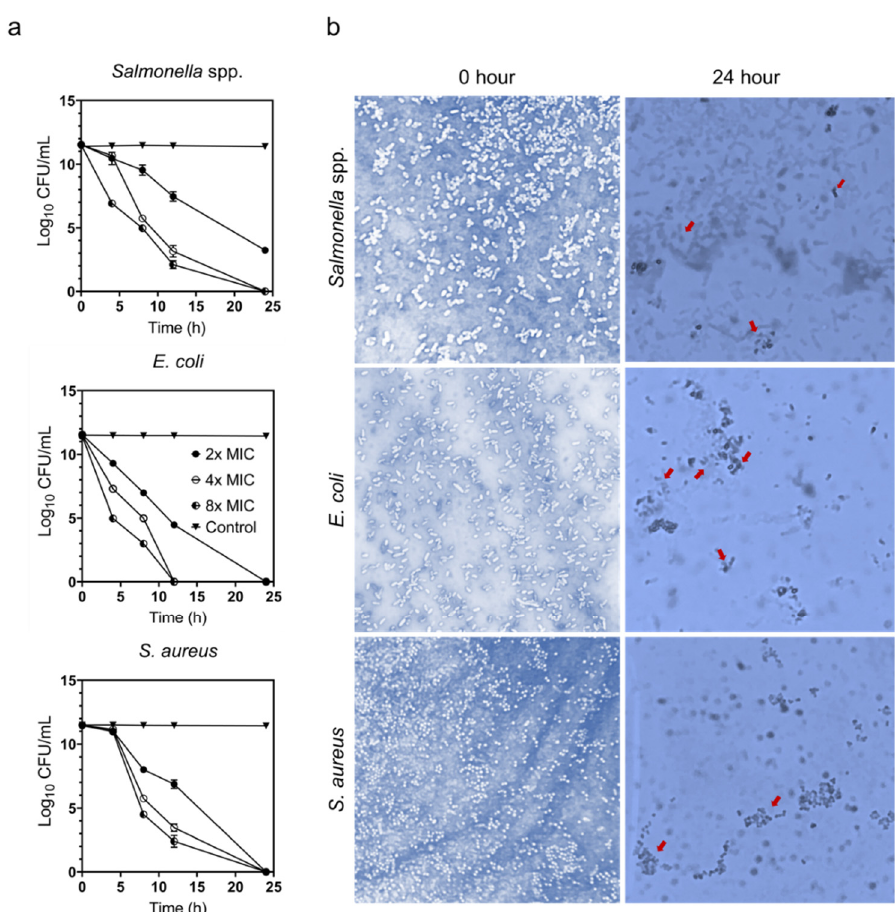
Figure 5. ( a ) Time–kill assay based on cell viability (log 10 CFU/mL) on the poultry-associated foodborne pathogens, Salmonella spp., E. coli , and S. aureus at the concentrations of 2×, 4×, and 8× MIC at different time intervals (0, 4, 8, 12, and 24 h). Bars represent the standard deviation of the mean for three replicates. ( b ) Trypan blue dye exclusion assay of Salmonella spp., E. coli , and S. aureus at 0 h and 24 h treated with ZnO NPs at the concentrations of 8× MIC. Dead cells are indicated with red arrows. The 0 h selection were used as a control of live cells. The images were taken using a light microscope at 100× magnification.